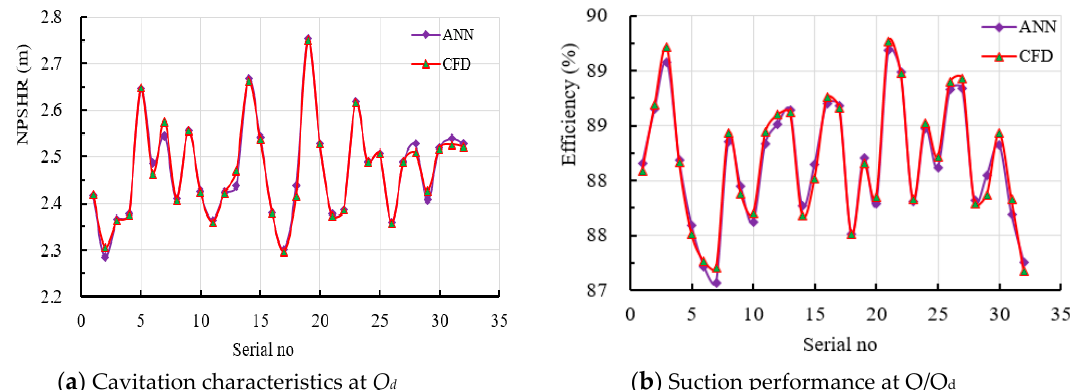
Figure 14. Validation of ANN prediction with CFD.